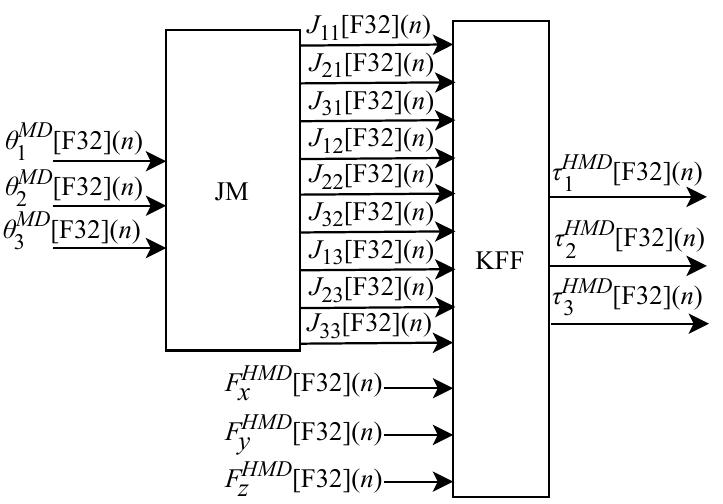
Figure 17. Proposed circuit to calculate kinesthetic feedback force (Equation (26))—KFF-HMD.